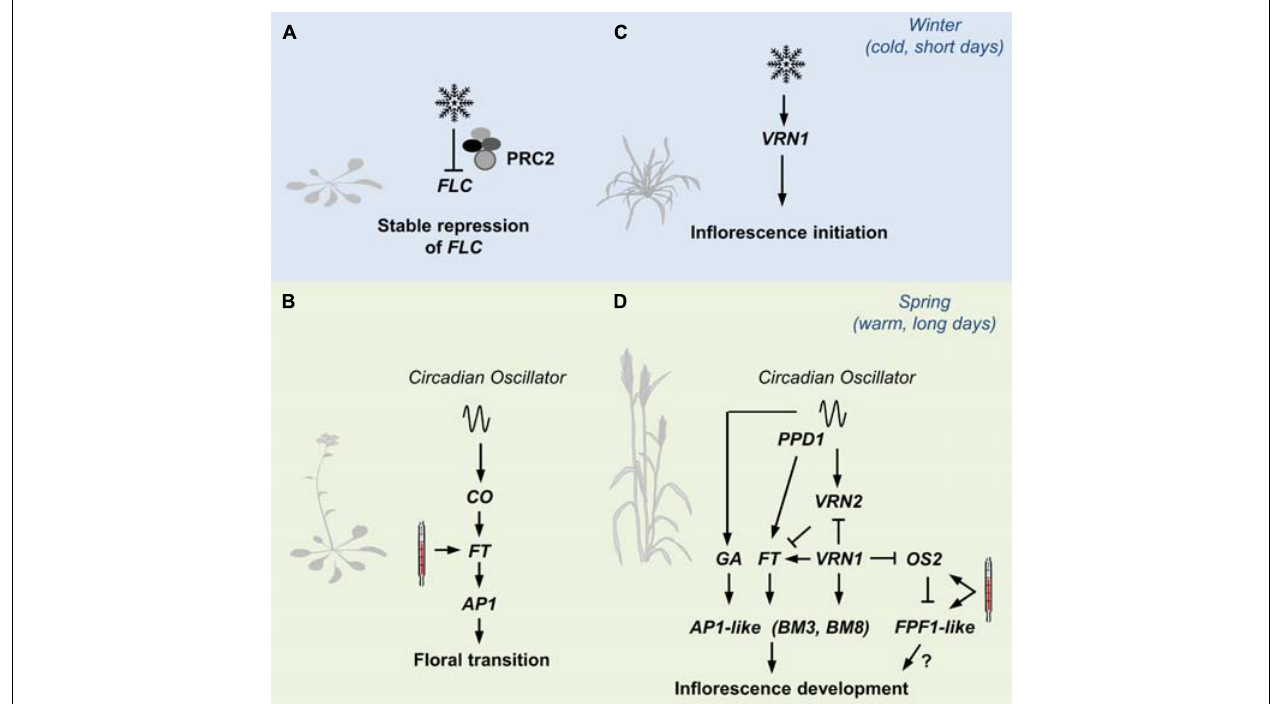
FIGURE 2 |An overview of pathways controlling seasonal flowering responses in grasses contrasted with those in Arabidopsis . (A) The prolonged cold of winter (snowflake) triggers lasting repression of FLOWERING LOCUS C ( FLC ) in Arabidopsis , via the Polycomb Repressor Complex 2 (PRC2). (B) The long days of spring activate expression of FLOWERING LOCUS T , a process mediated by the circadian oscillator via CONSTANS ( CO ). FT activates expression of genes such as a APETALA1 that trigger floral development. High-temperatures (thermometer) can also activate expression of FT to accelerate flowering. (C) Winter cold activates expression of VERNALIZATION1 ( VRN1) in cereals and